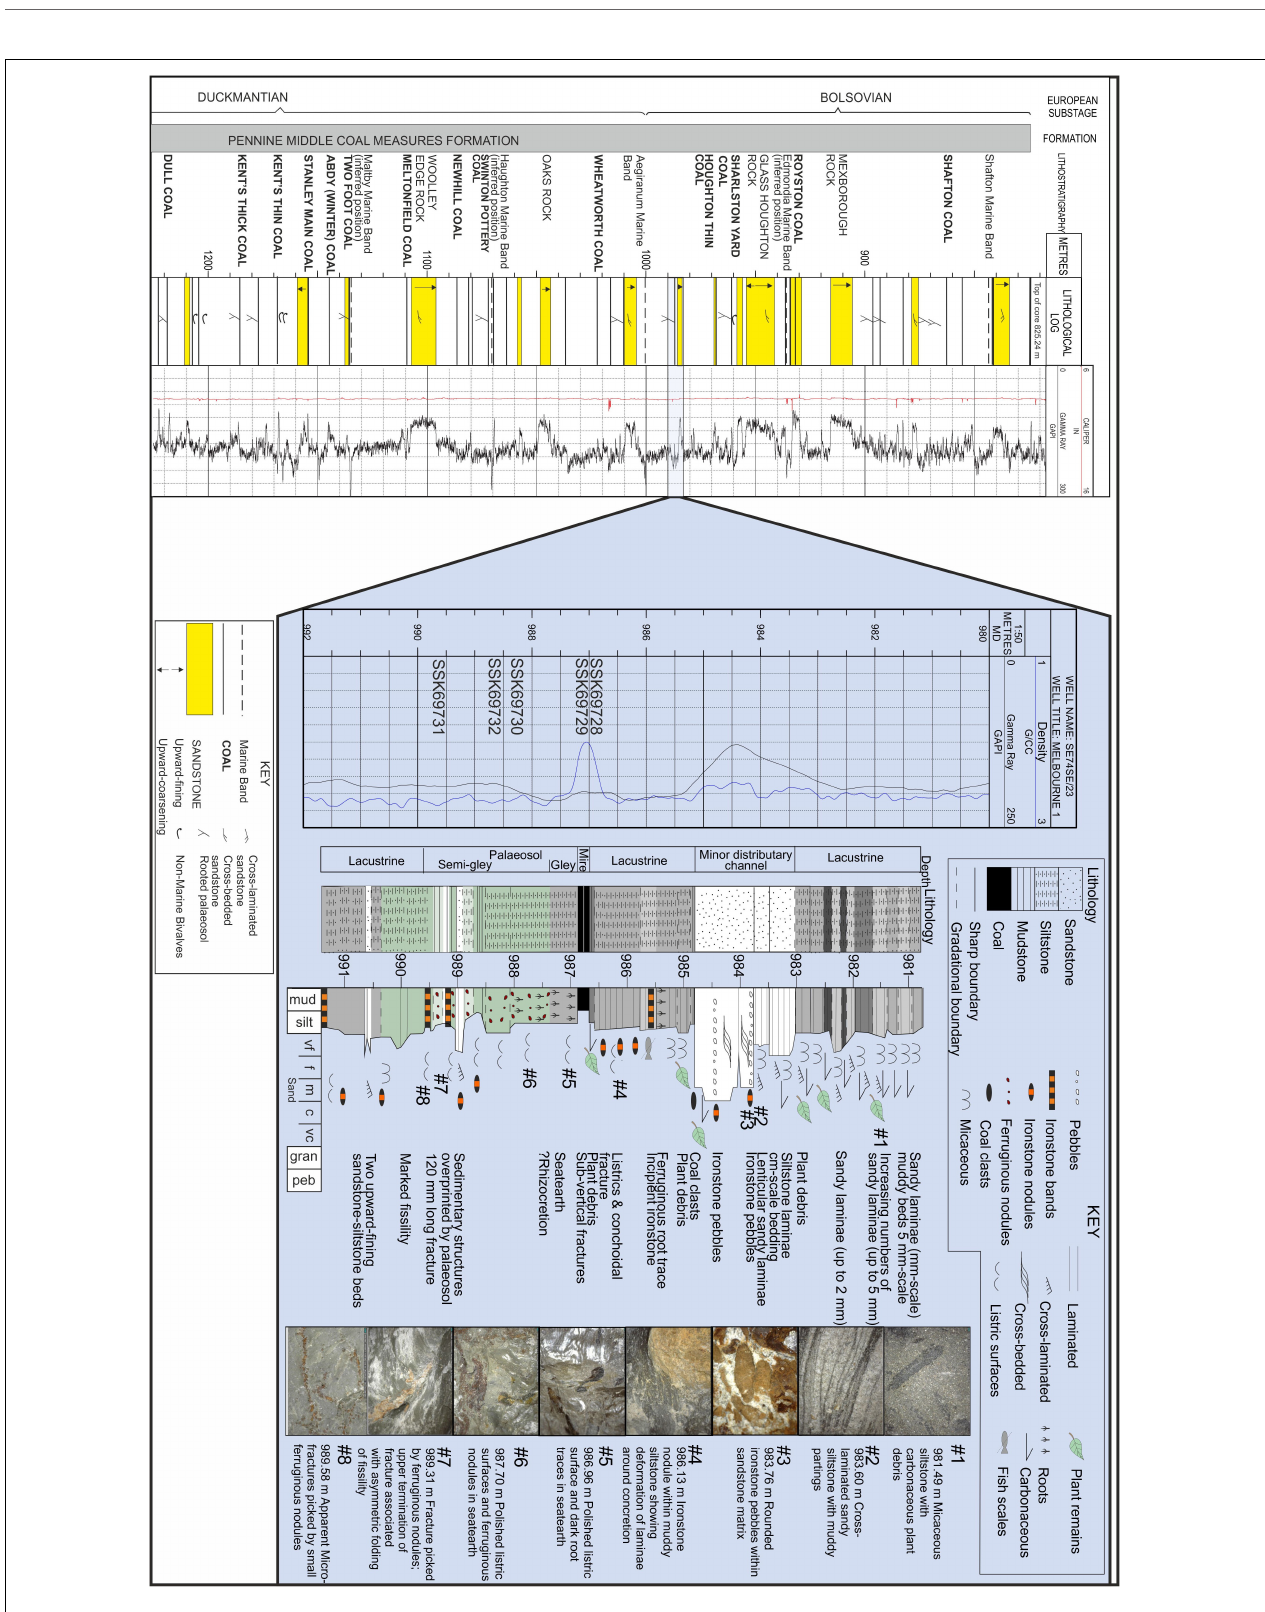
FIGURE 3 | Stratigraphic log of the Pennine Coal Measures (PCM) proved in the Melbourne 1 borehole and the section of interest highlighted in Figure 2A . Location of Petrography samples are also shown ( Table 2 ) and are described in the section “Materials and Methods.”